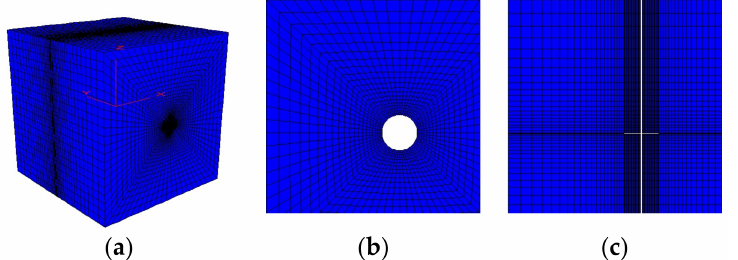
Figure 9. The geometry of the model showing the borehole and grid pattern: ( a ) 3D View; ( b ) Elevation view; ( c ) Overhead